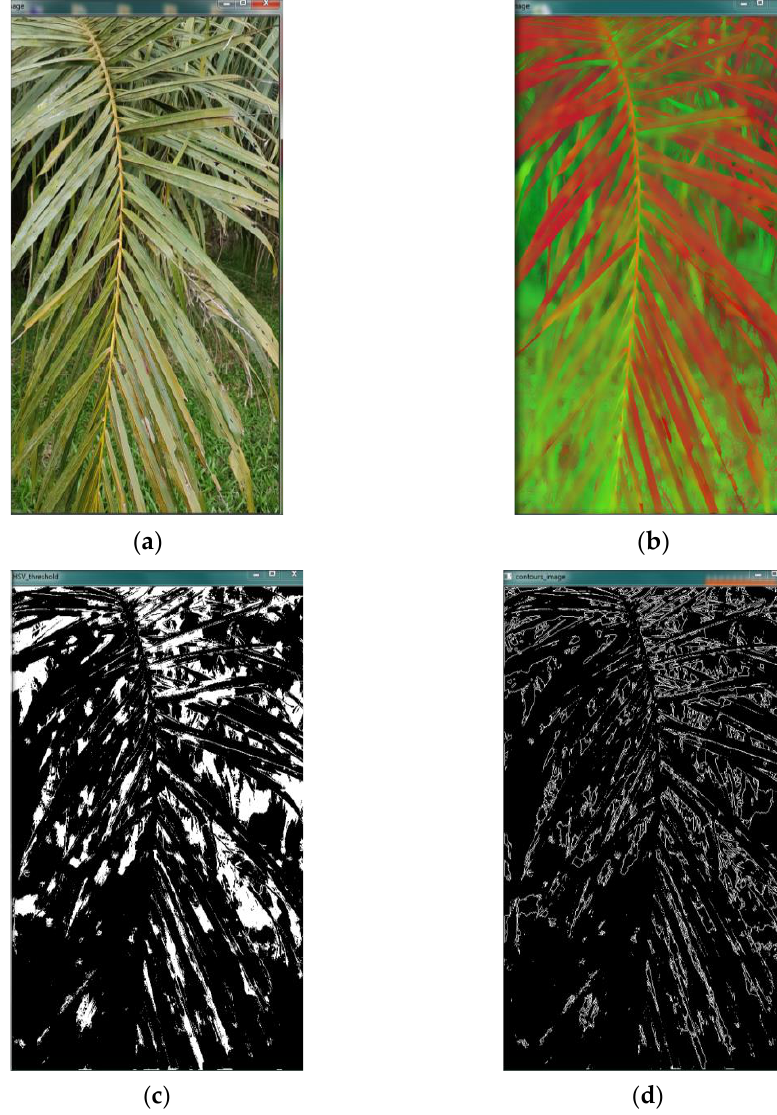
Figure 8. Analysis of leaf blight and tattering in palm tree (original resolution: 4032 × 3024) ( a ) Orig- inal image ( b ) Bilateral blur-based segmented HSV Image ( c ) Thresholding of segmented image ( d ) Defining contours.